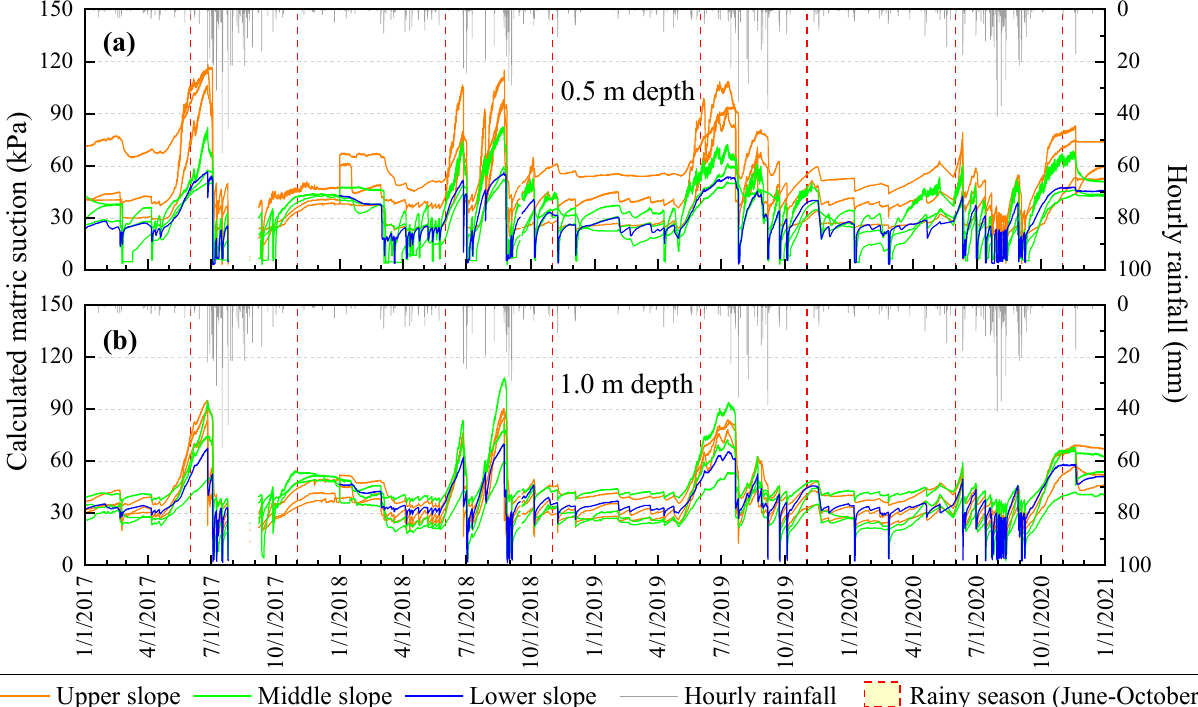
Figure 9. Four-year variations in matric suctions estimated in ( a ) 0.5 m and ( b ) 1.0 m soil depths at each of the three sections in the Songnisan landslide monitoring station.